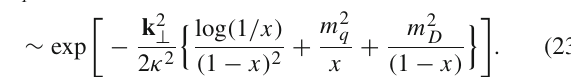
Fig. 5 (Color online) Plots of first three moments of the helicity-dependent GPDs for zero skewness vs. quark and the right panel is for d quark The moments of the other GPD, same way as (21). The first moments of (cid:2) ( x , 0 , t ) give the axial-vector form factor, G q E q n 0 pseudo-scalar form factor, G q p ( t ) , for quark q ,